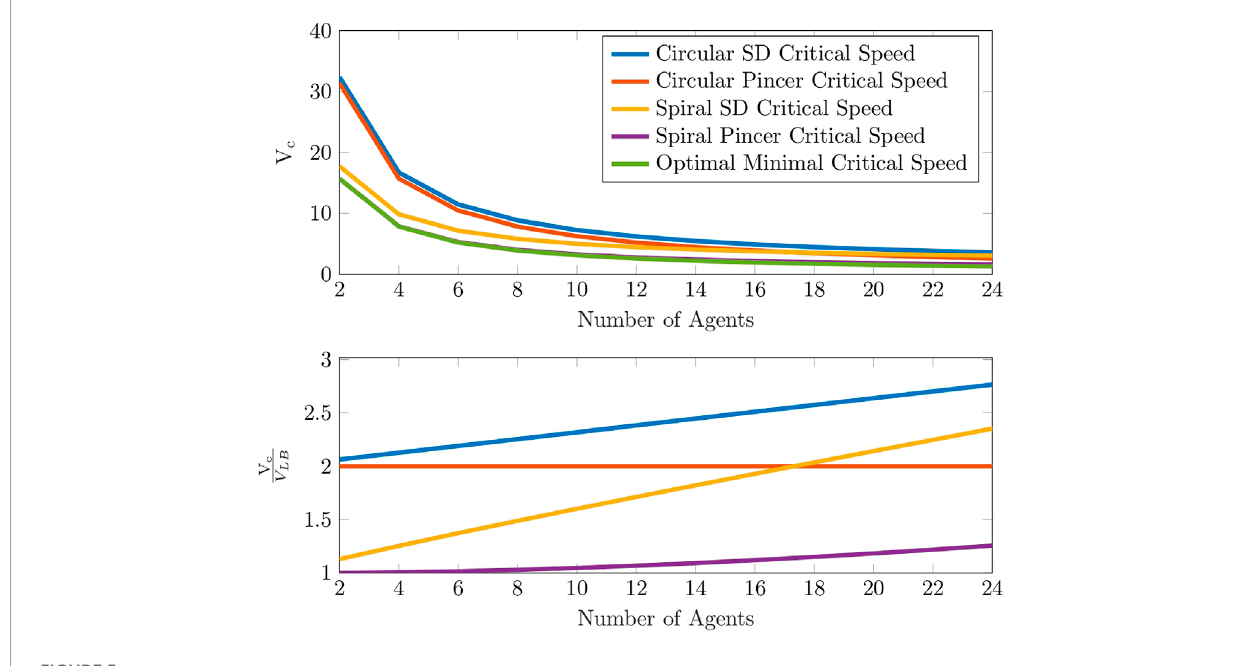
FIGURE 5 Critical speeds as a function of sweepers’